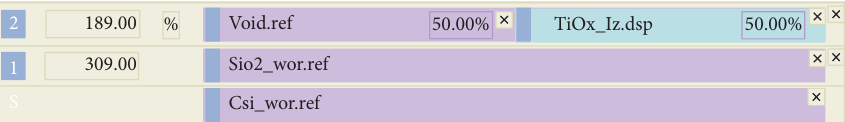
Figure 4: Fitting procedure for the wafer films coated with NMO-TiO 2 .